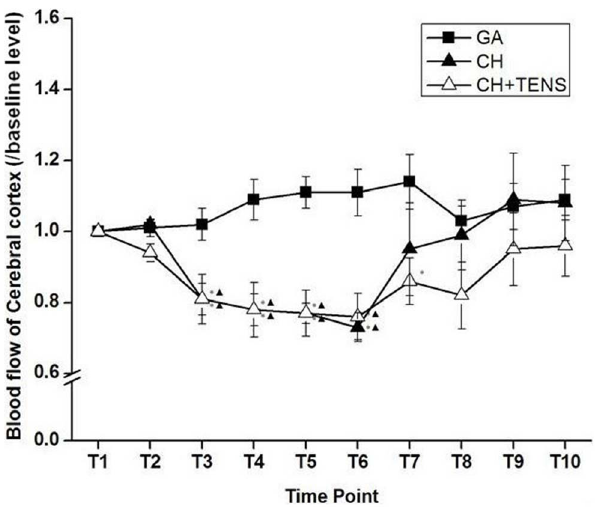
Figure 5. Blood flow to the stomach during controlled hypotension (CH). Gastric blood flow in the CH group was significantly less than baseline levels when mean arterial pressure (MAP) was lowered to reach target pressures and during the first 10 min of maintenance (T 3 –T 4 ). TENS significantly prevented the decreased perfusion to the stomach. During the maintenance and MAP restoration stages (T 5 –T 10 ), gastric blood flow in the CH group decreased significantly regardless of the cessation of SNP infusion. TENS also effectively inhibited the hypo-perfusion to the stomach in this period. By the end of T 10 , TENS was able to accelerate the recovery of low blood flow to the stomach caused by long-term hypotension. Data are presented as mean 6 standard error of the mean. * P , 0.05 vs. GA group, m P , 0.05 vs. basal level, # P , 0.05 vs. CH group, n=6 per group.